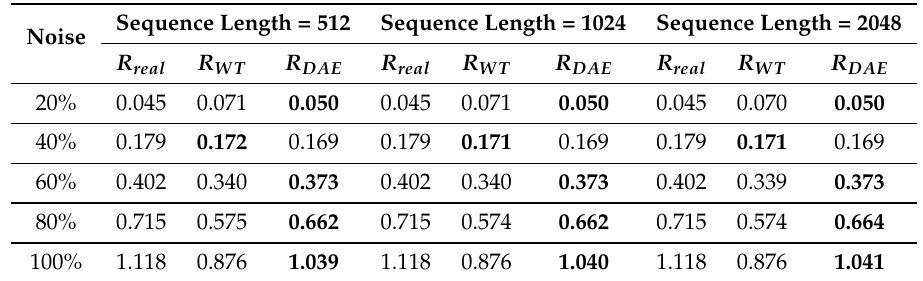
Table 5. Measurement noise variance accuracy on power data of different sequence lengths. The boldface numbers denote the best value in each